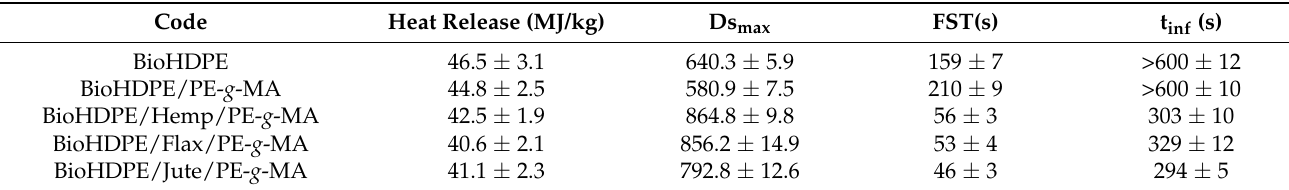
Table 7. Summary of thermal parameters obtained with the calorimetry and opacity test on BioHDPE composites with different natural